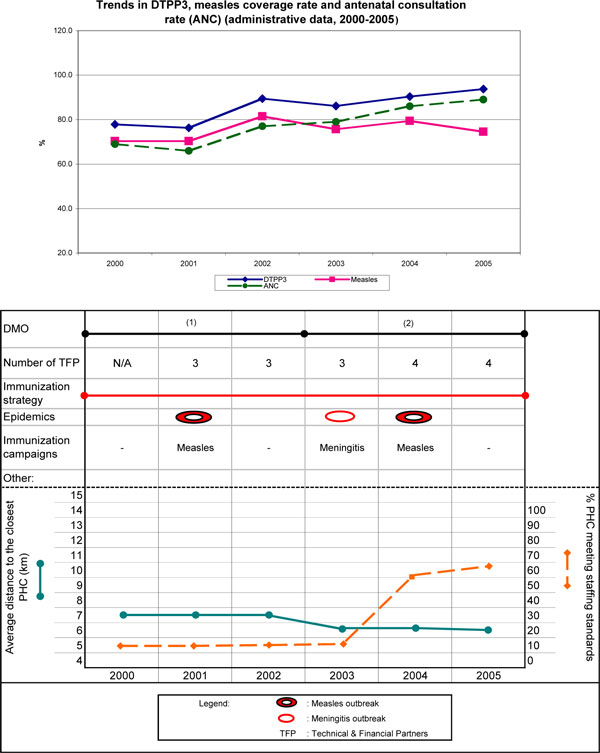
Health district of Koya.